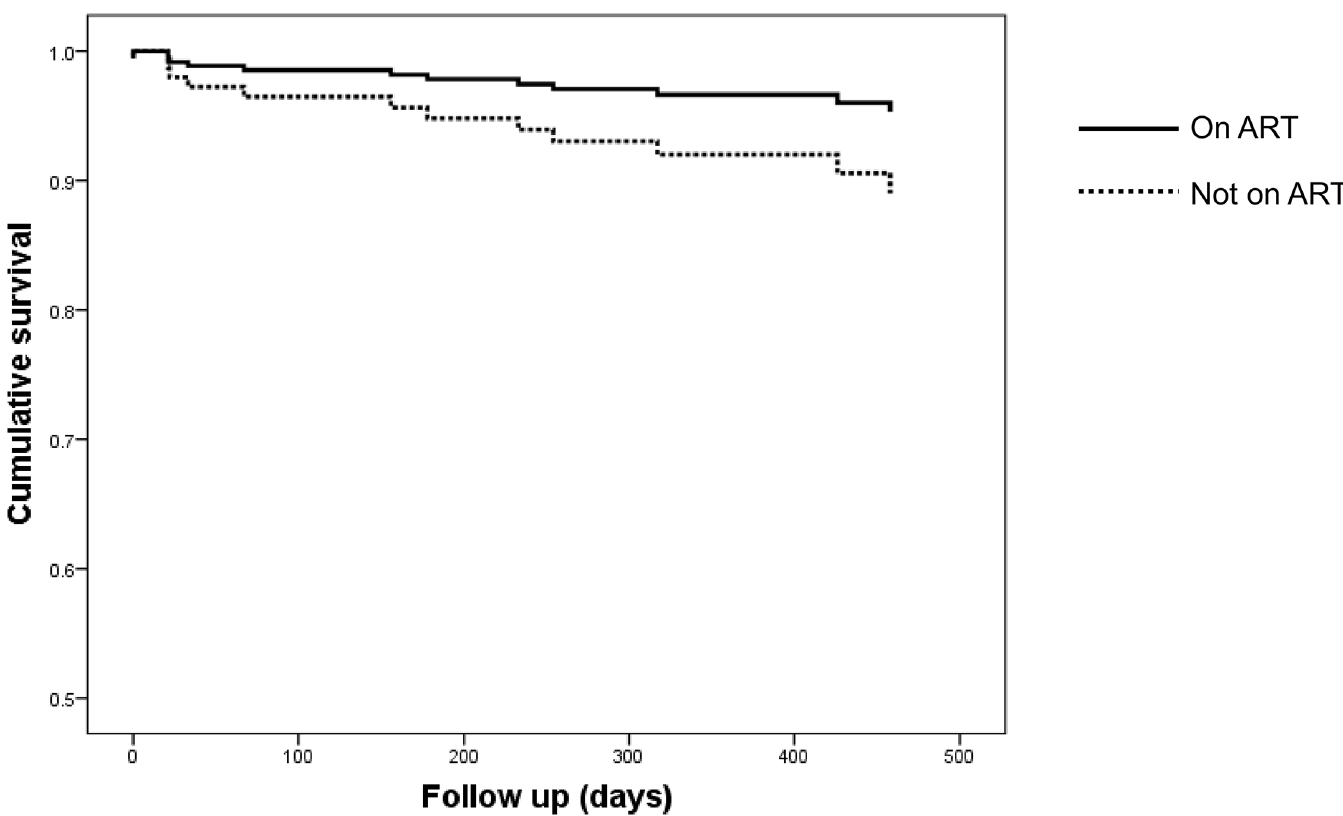
Fig 3. Time to death. Kaplan Meier curves of time to mortality (in days) of patients who started ART versus patients who did not start ART during the first 2 visits to the clinic. There was a trend towards a reduced mortality in patients who started ART.